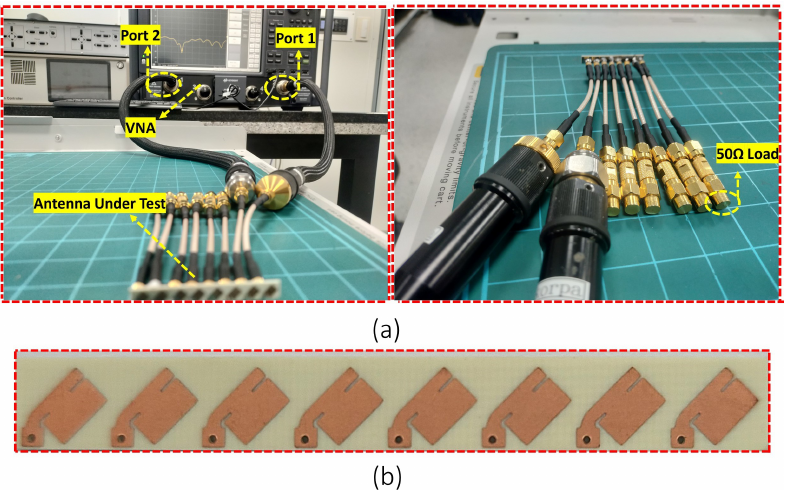
Figure 3. ( a ) Measurement setup for S-parameter. ( b ) Fabricated